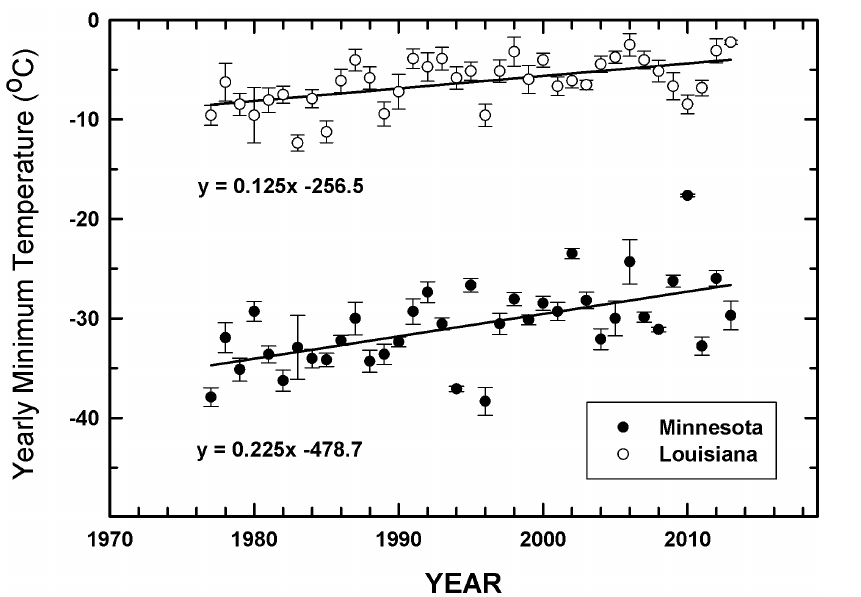
Figure 3. Change in average ( 6 SE) minimum temperature (lowest recorded temperature for a 24 h period during a given calendar year for four locations) for the northernmost and southernmost states (Minnesota, closed circles) and Louisiana (open circles) used in the Midwestern transect. Slope of the regression line indicates the average increase in minimum temperature ( u C) per year for each location.